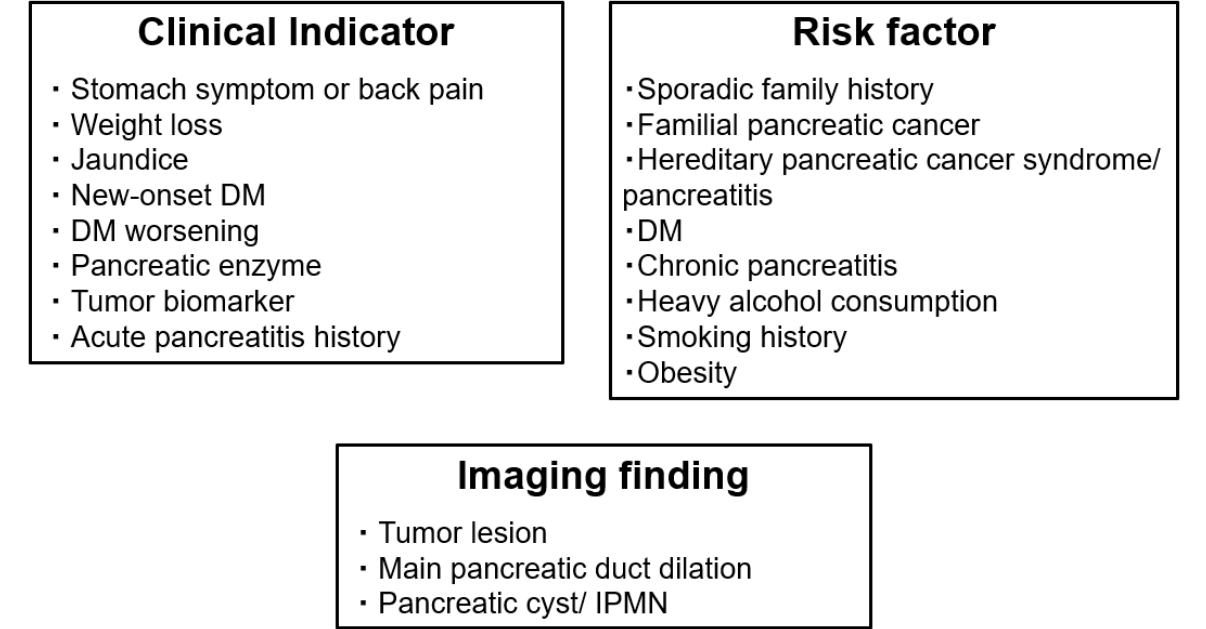
Figure 1. Newly classified factors associated with early stage PDAC detection: clinical indicators, risk factors, and indirect imaging findings. Well-known factors associated with PDAC were newly classified into three categories: clinical indicators (may be caused by PDAC onset), risk factors (may be the cause of PDAC onset), and imaging findings are concomitant with early PDAC. DM, diabetes mellitus; IPMN, intraductal papillary mucinous neoplasm; PDAC, pancreatic ductal adenocarcinoma.